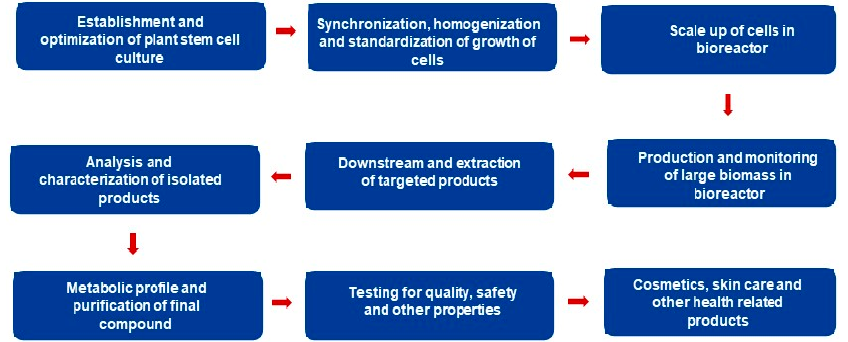
Figure 3. Flow chart of plant stem cell cultivation and product synthesis.